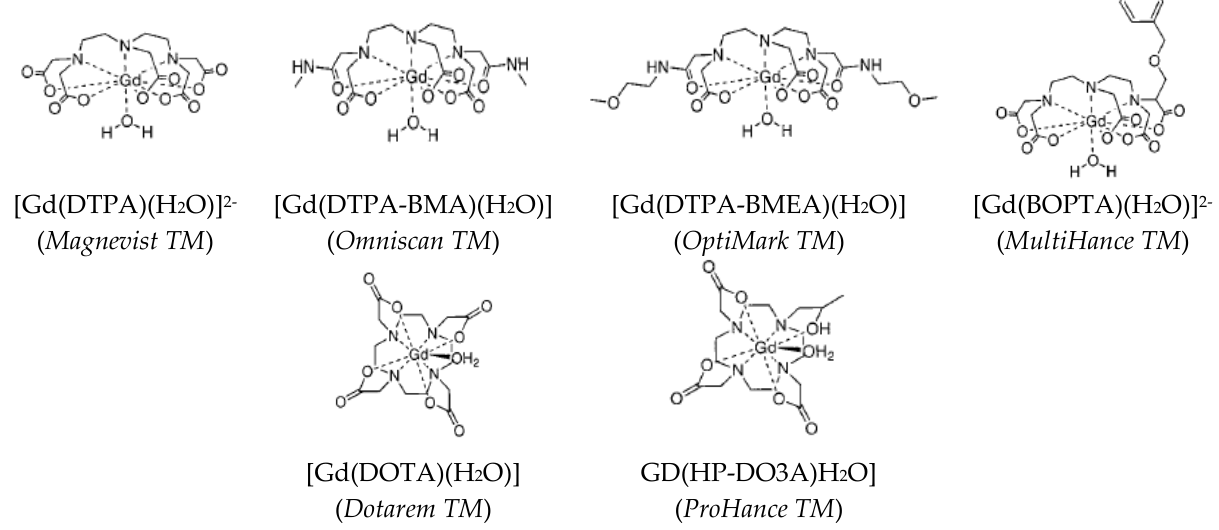
Figure 2. The semi-developed formula of Gd-chelates involving linear ( top ) or cyclic ( down ) ligands (the commercial names are given in parenthesis). Reproduced from [2], with permission from ACS, 1999 The most used paramagnetic cation for this purpose is Gd 3+ . This cation has a high electronic magnetic moment thanks to its seven non-paired 4f electrons. When submitted